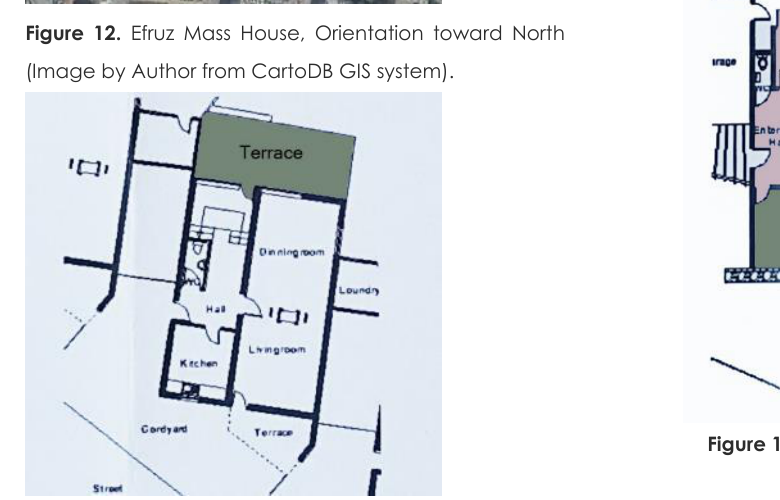
Figure 13. Terraces of Efruz Houses oriented to the south (Esentepe, 2013).